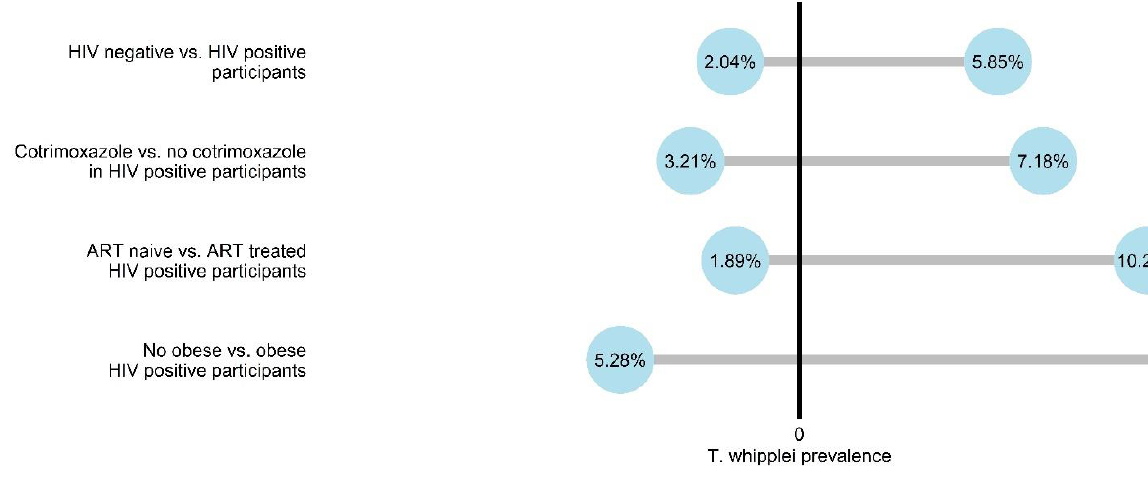
Figure 1. Prevalence of T. whipplei according to cohort characteristics. HIV positive participants with present or absent T. whipplei were not different with regards to age, sex, or any of the recorded socioeconomic factors (Table 1). Furthermore, frequencies of clinical symptoms were not found to be higher in HIV positive T. whipplei carriers compared to T. whipplei negative participants. Table 1. Demographical and socioeconomic parameters, and clinical symptoms in HIV infected individuals according to T. whipplei status.